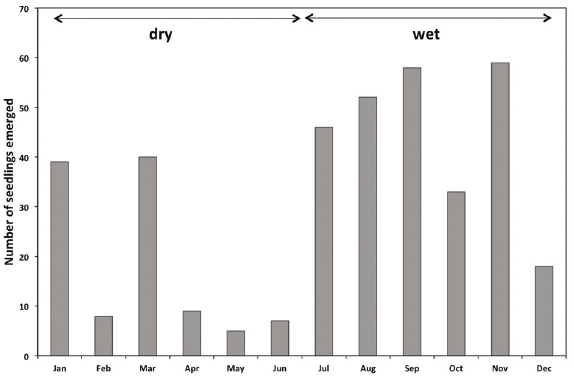
Figure 3. The number of Serianthes nelsonii seedlings that emerged in 2013 for each month. Dry and wet refer to major annual seasons.